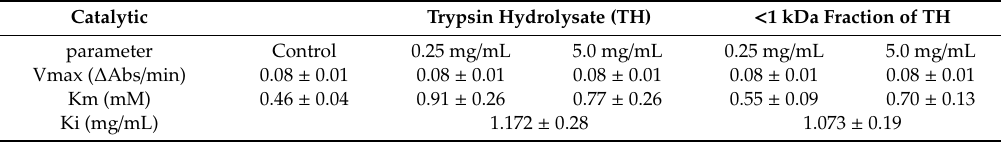
Figure 4. Lineweaver–Burk plots of trypsin inhibition at di ff erent peptide concentrations: ( A ) trypsin hydrolysate ( R 2 = 0.99, 0.89, and 0.87 for 0.0, 0.25, and 0.5 mg / mL, respectively) and ( B ) trypsin hydrolysate < 1 kDa peptide fraction ( R 2 = 0.99, 0.98, and 0.96 for 0.0, 0.25, and 0.5 mg / mL, respectively). Table 2. Kinetics constants for trypsin inhibition by protein hydrolysate and peptide fraction.